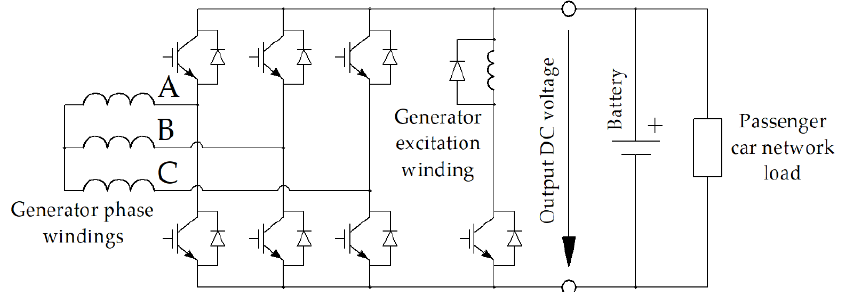
Figure 2. Scheme of rectifying the output current of the generator to the car network. Capital letters denote the phases A, B, C of the generator.